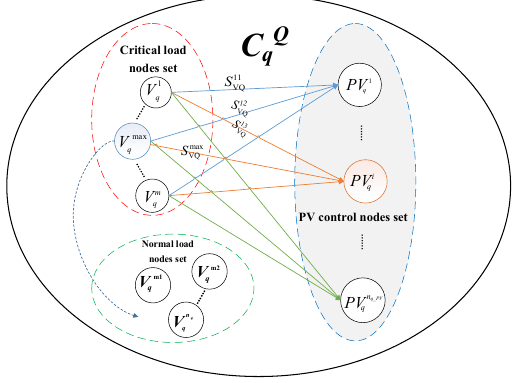
Figure 2. Process of the real-time zonal voltage control.